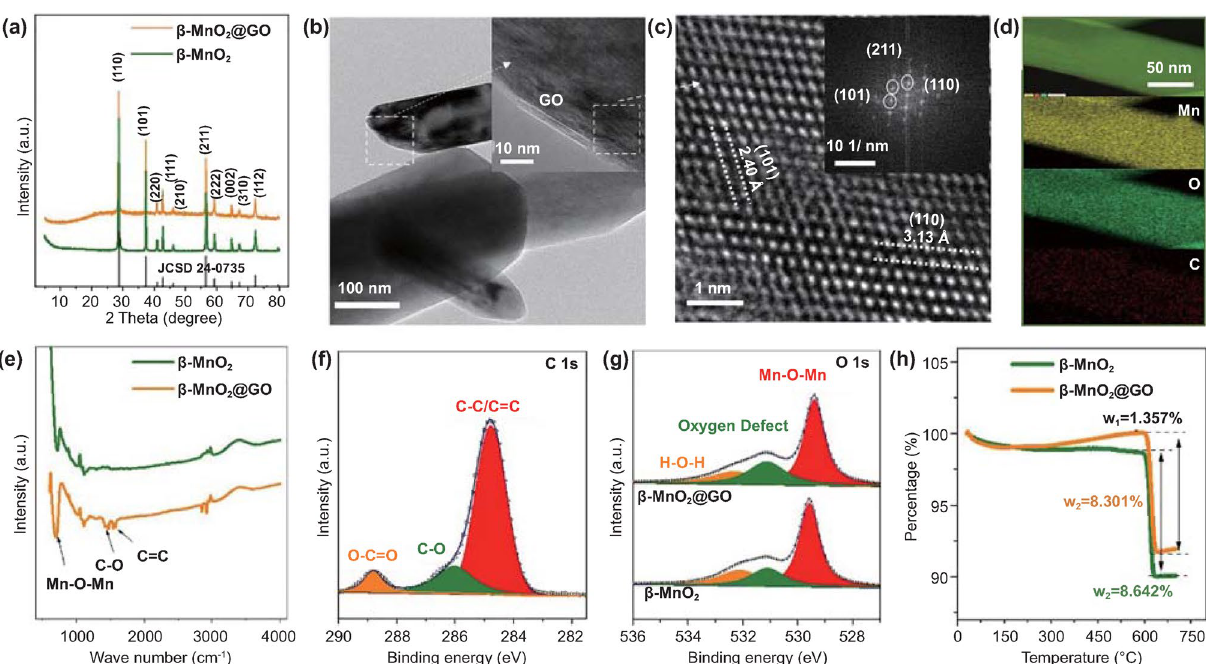
Fig. 1 a XRD patterns of β-MnO 2 and β-MnO 2 @GO. b–d TEM, HRTEM morphologies, and correlated EDS mapping results of β-MnO 2 @ GO (the insets in b and c show the presence of GO layer and the diffraction pattern, respectively). e comparison of FTIR spectra of β-MnO 2 and β-MnO 2 @GO. f XPS peaks of C 1 s and g O 1 s spectra. h TGA curves of β-MnO 2 and β-MnO 2 @GO in an O 2 -containing